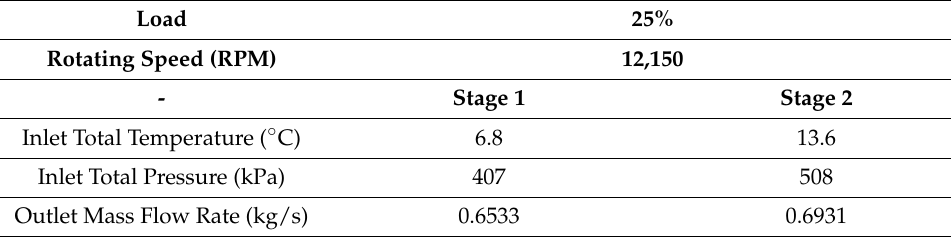
Table 8. Boundary conditions for two-stage IPLV load